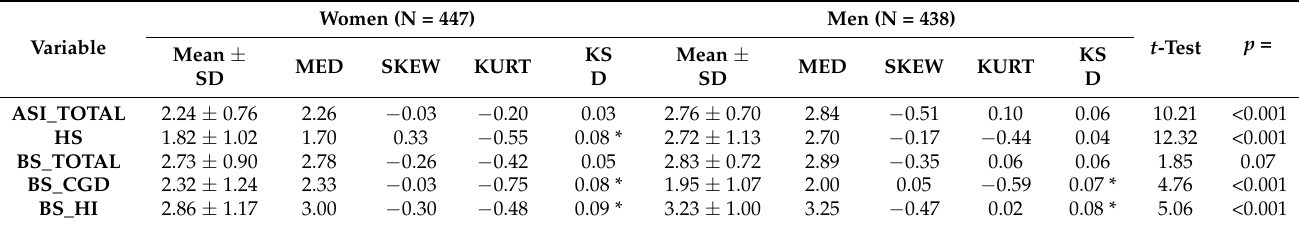
Table 4. Gender differences and sensitivity of validated ASI